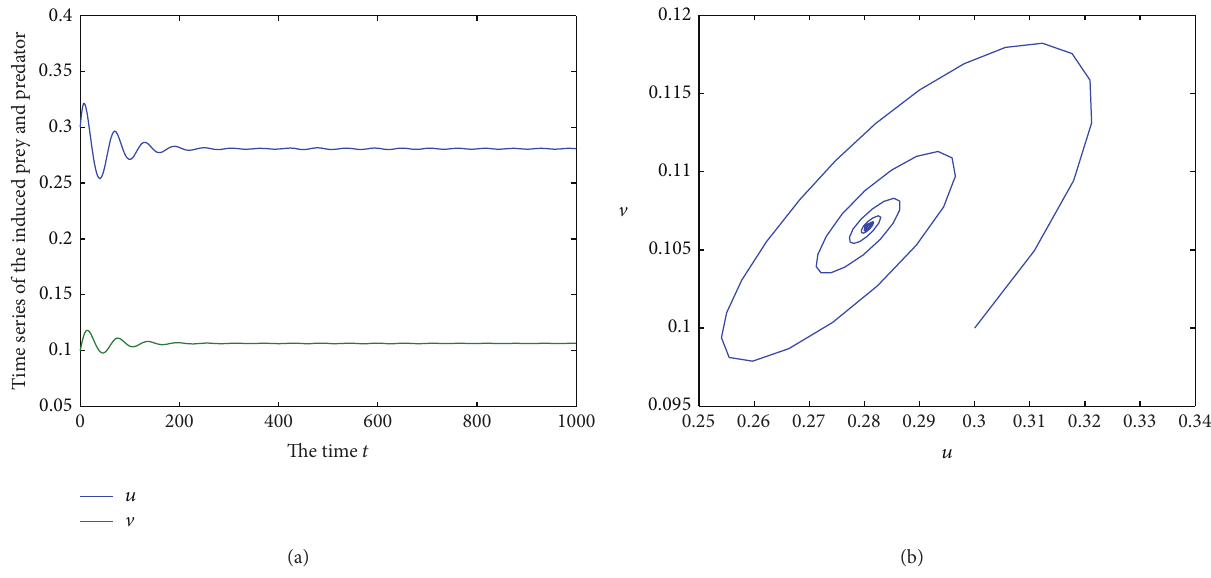
Figure 1: Behavior and phase portrait of system (6). Parameter values are used as 𝛼 = 0 . 6, 𝛽 = 0 . 8, 𝛾 = − 0 . 3, 𝛿 = 0 . 58, 𝜃 = 2 . 2, and 𝜏 = 0 . 2 < 𝜏 𝑐 .